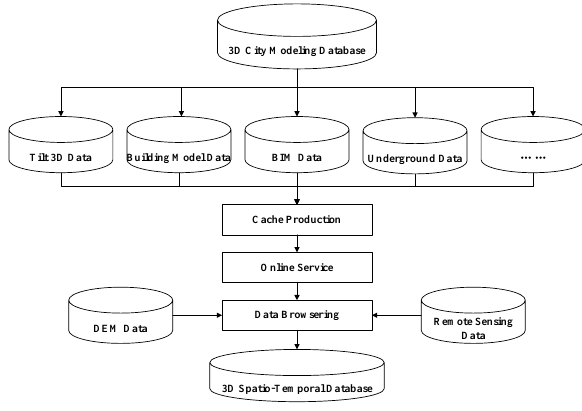
Figure 1 . General Design of 3D City Modeling Database Construction and Display